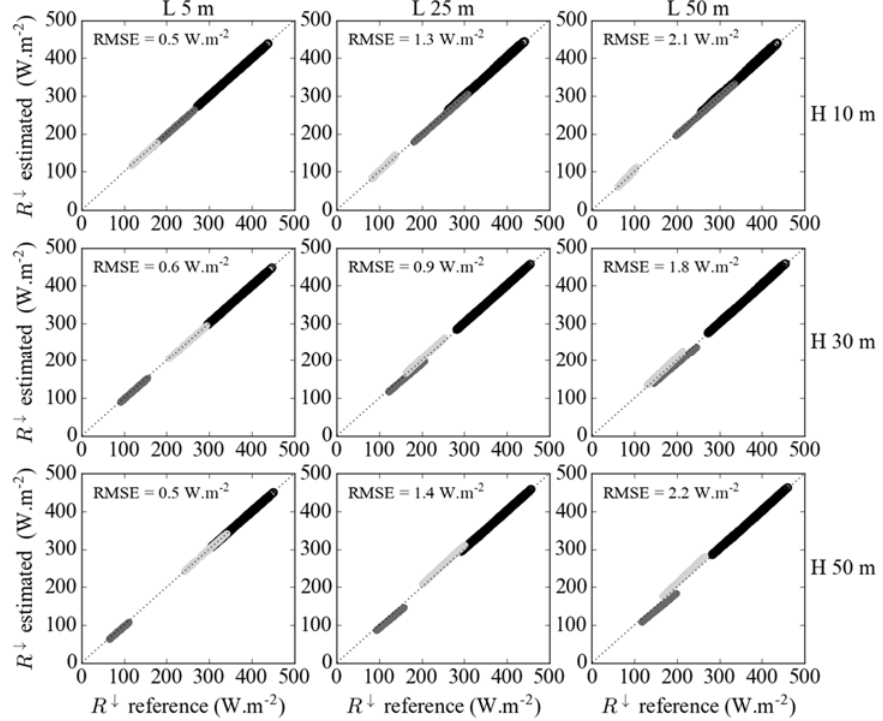
Figure 6. Comparison of estimated and reference total (black circles), atmospheric (dark grey dots) and scene (light grey dots) downwelling TIR radiation for nine canyon configurations (orientation 0°). The Root Mean Square Error (RMSE) is provided for the estimation of the total downwelling TIR radiation.